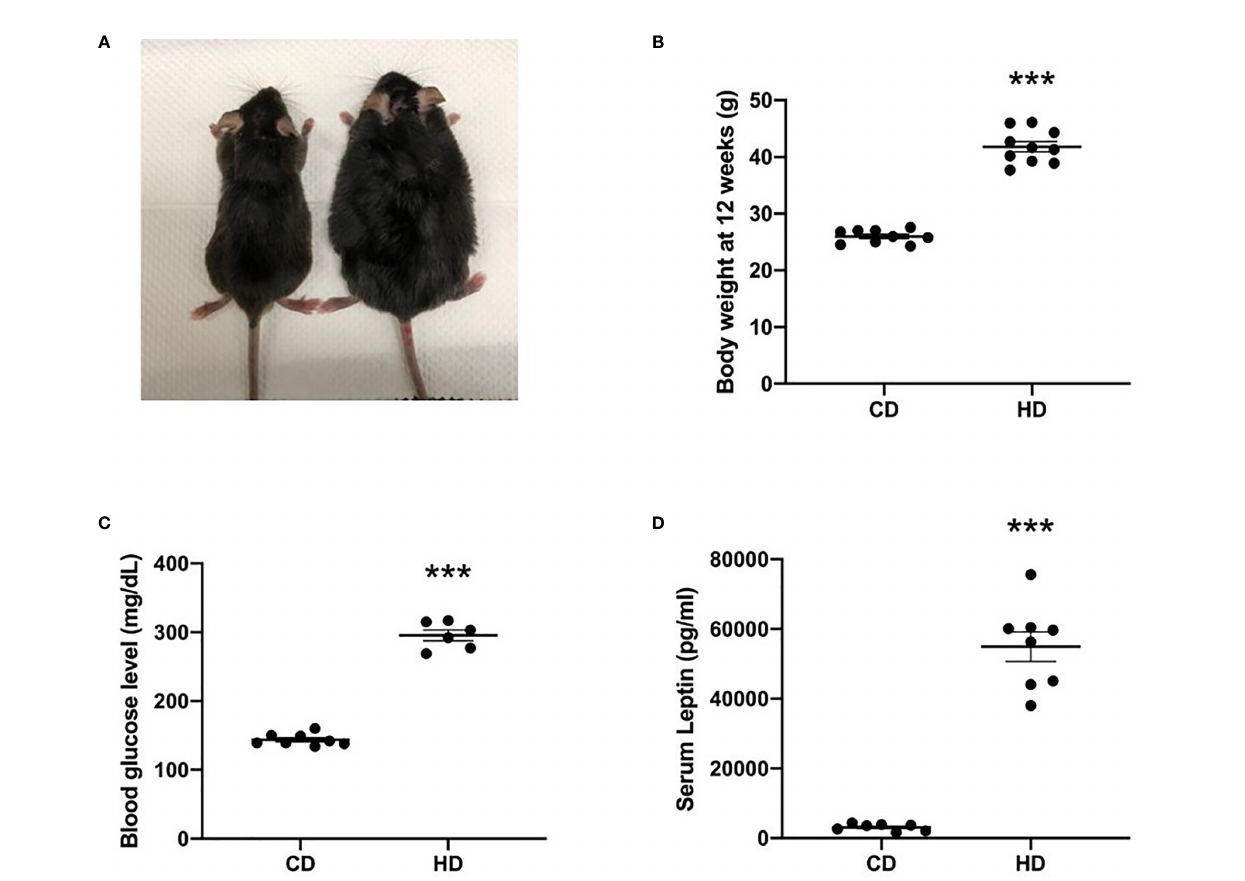
FIGURE 1 | Comparison of nonobese (CD) and obese (HD) mice. (A) Gross appearance, (B) body weight at the age of 12 weeks, (C) blood glucose level, and (D) serum leptin level. Data are expressed as the mean ± SD. *** P < 0.001 compared with the nonobese group